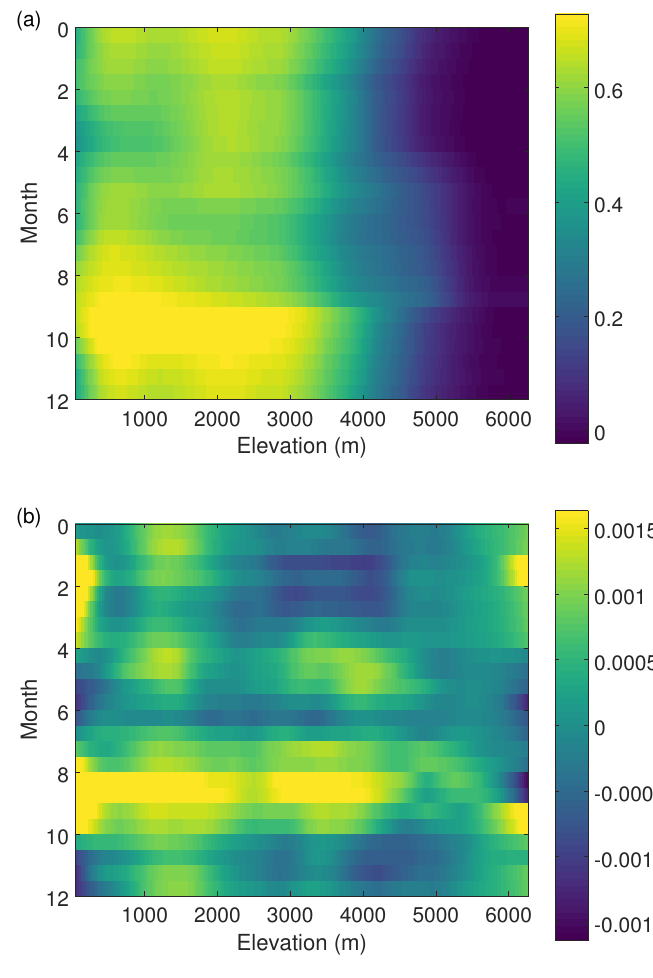
Figure 6. ( a ) Mean normalized difference vegetation index (NDVI; unitless), and ( b ) 1981–2015 linear trend in NDVI (10 − 3 per year) for Nepal, by season and